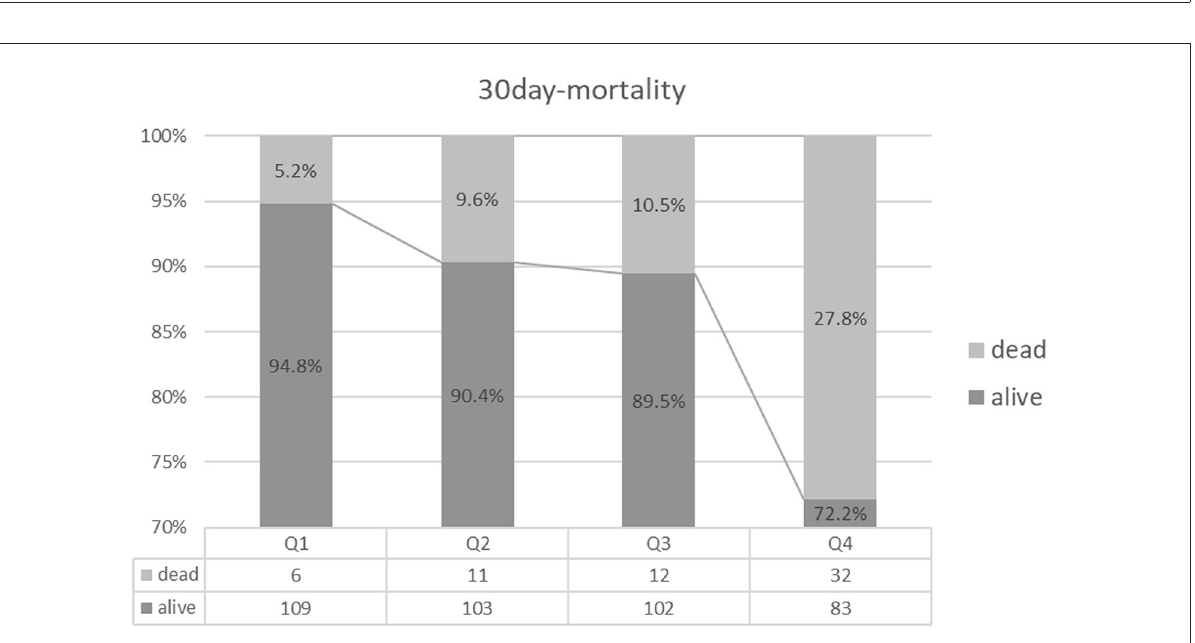
FIGURE3 30 day-mortality comparison among the quartile